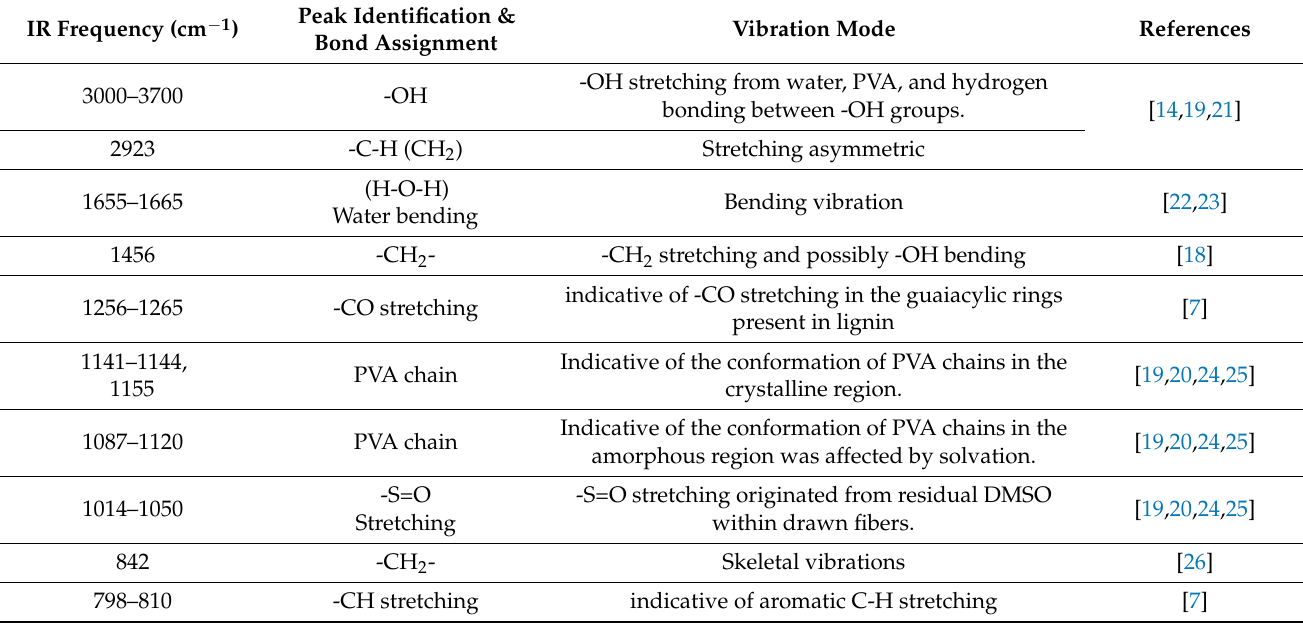
Figure 9. IR absorbance spectra of Lignin/PVA fibers. Table 3. Identification of FTIR peaks in Lignin/PVA/SPA blend Fibers.